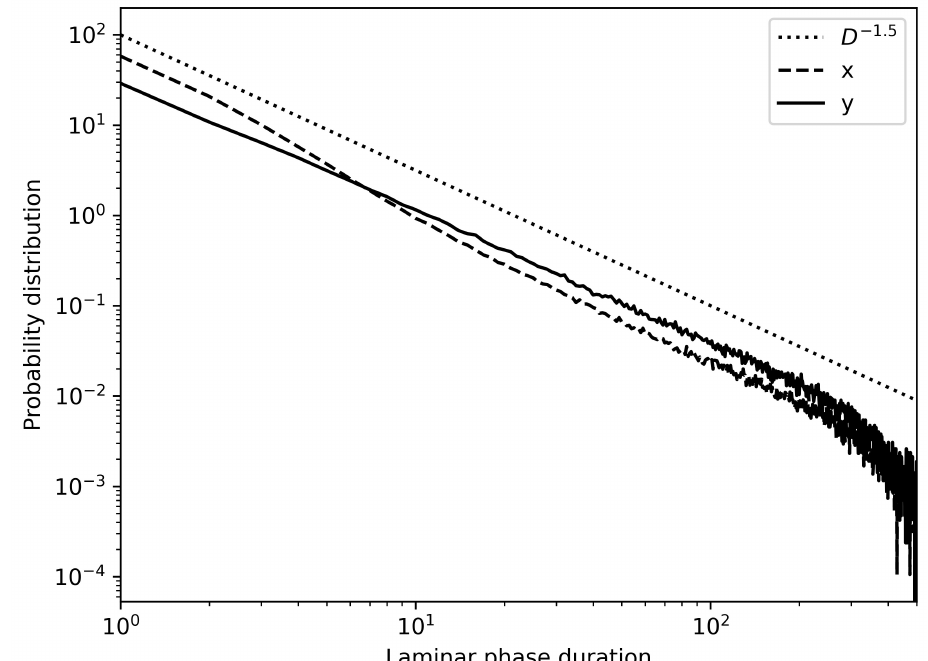
Figure 3. Duration of the off (laminar) phases of the x (dashed) and y (solid) components with a stochastic a 1 parameter in the Hastings–Powell model. The dotted line indicates a dependence proportional to D − 3 2 .